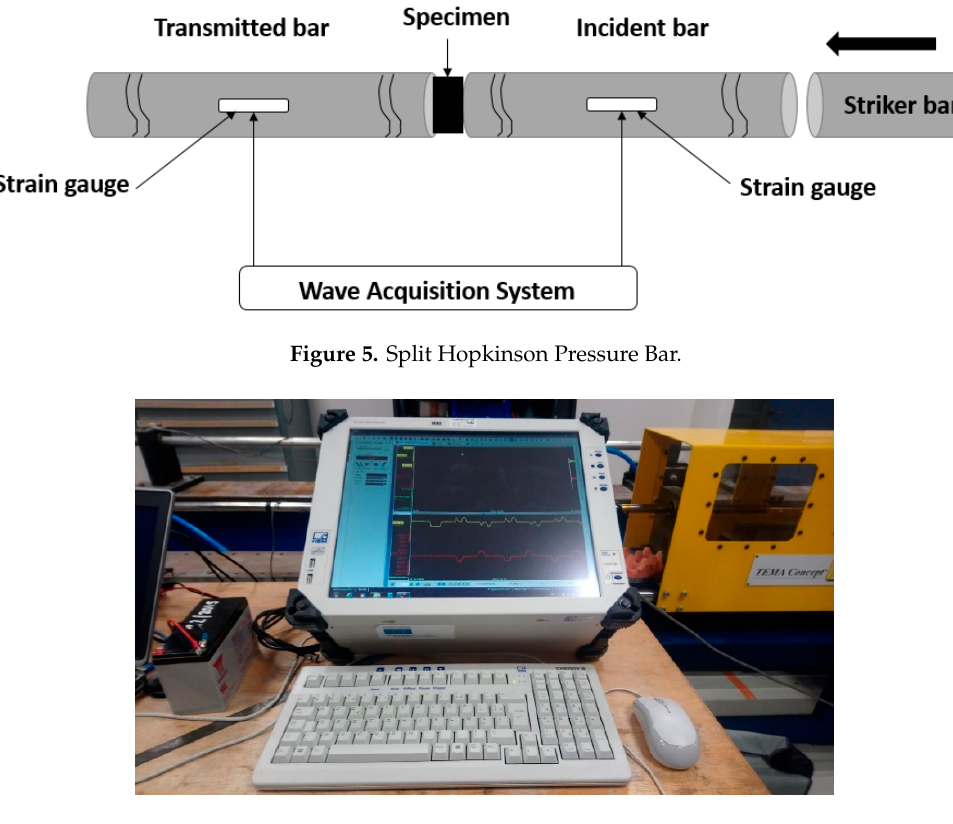
Figure 6. Digital oscilloscope. Figure 6. Digital